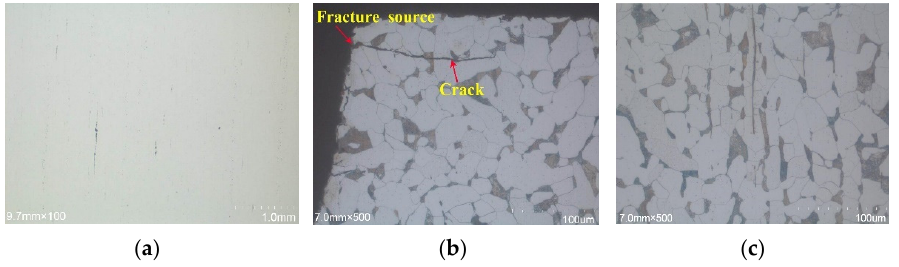
Figure 6. Microstructure of the fractured wheelset lifting mechanism: ( a ) nonmetallic inclusions of the fractured lifting mechanism at 100× magnification; ( b ) micro-morphology of the fracture source at 500× magnification; ( c ) micro-morphology of the fracture’s center at 500× magnification.